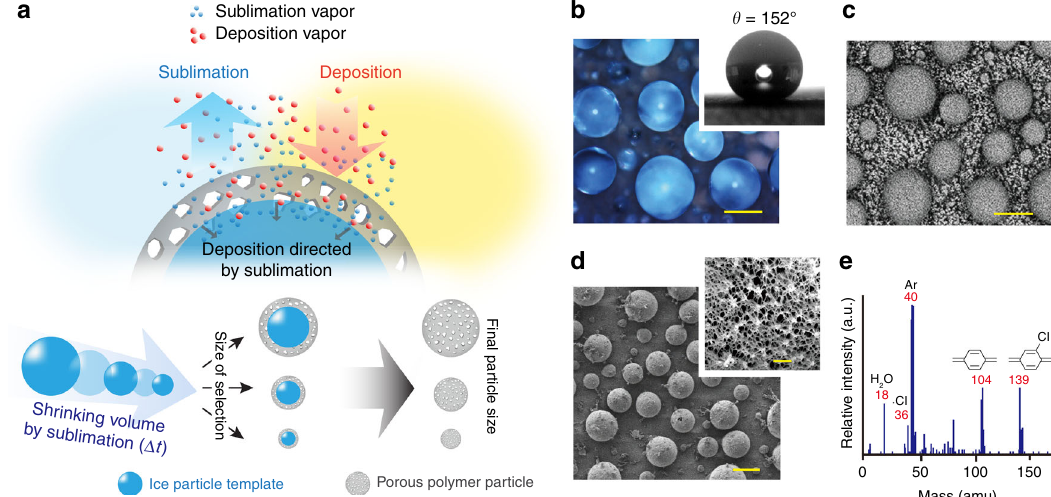
Fig. 1 Fabrication via sublimation-directed vapor deposition. a Schematic illustration of the deposition/sublimation process used to construct micro- and nanosized porous particles. b Optical micrograph showing water droplets on a superhydrophobic surface, scale bar: 50 μ m; a 152° water contact angle is shown in the top inset. c Cryo-SEM micrograph showing the ice particles (templates) created from the water droplets, scale bar: 50 μ m. d SEM micrograph showing the polychloro- para -xylylene particles produced via vapor deposition on the ice particle templates, scale bar: 50 μ m. The porous structure with pore size 532.3 ± 89.3 nm formed within the polychloro- para -xylylene particle, as indicated in the top inset (scale bar: 5 μ m). e A mass spectrum recorded during the sublimation/deposition process showing the signals for the sublimated water molecule (18 amu), chloride ion (36 amu), p-quinodimethane (104 amu), and chloro-p-quinodimethane (139